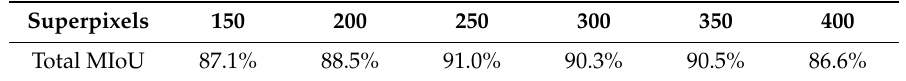
Table 8. Total MIoU results of Yamaguchi parameters combined with di ff erent SLIC